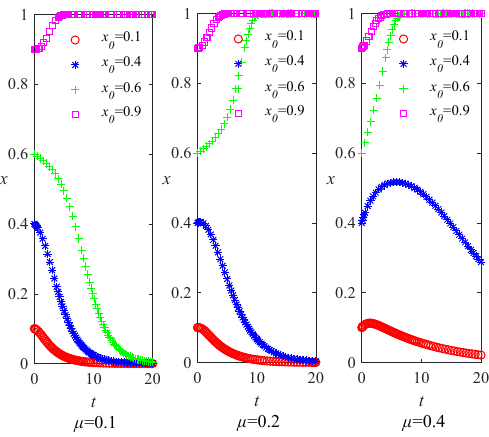
Figure 13. The impact of government supervision on system evolution results.